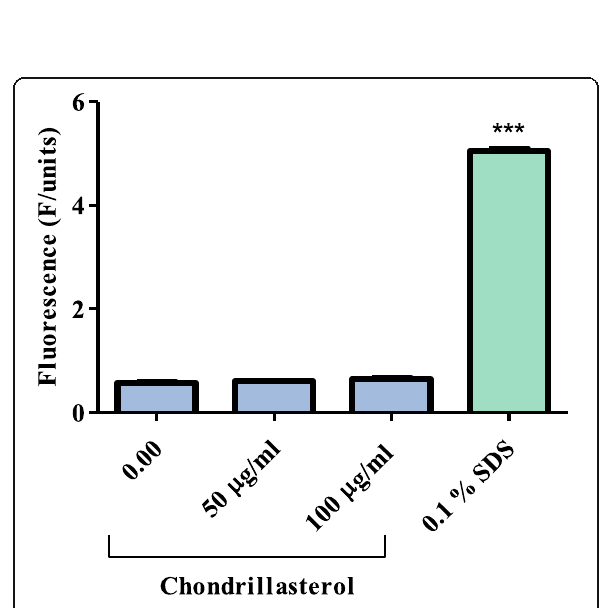
Fig. 5 The effect of chondrillasterol on nucleic acid leakage in P. aeruginosa. Cells and control (0.1% SDS) were exposed to chondrillasterol in triplicate and the nucleic acid leakage was quantified. The test for significance was carried out by comparing the fluorescence of the samples to untreated cells (cells only), *** P <0.0001. SDS: sodium dodecyl